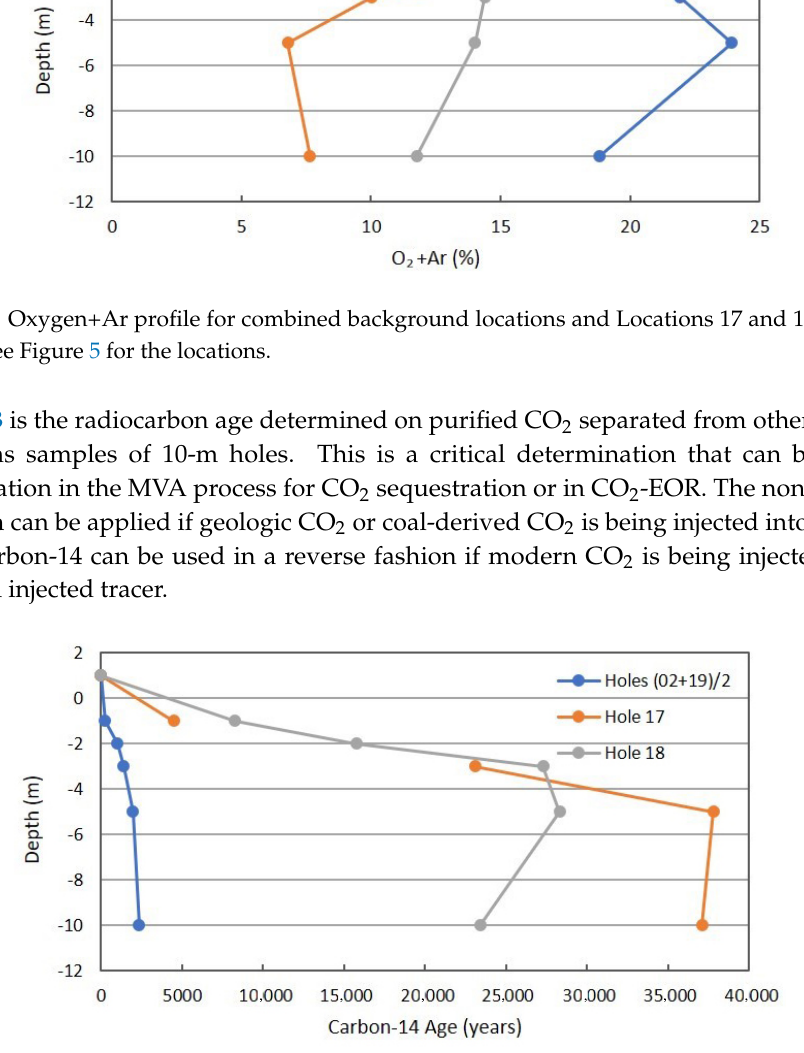
Figure 13. Radiocarbon profile for combined background locations and Locations 17 and 18 in Fault Zone 2. See Figure 5 for the